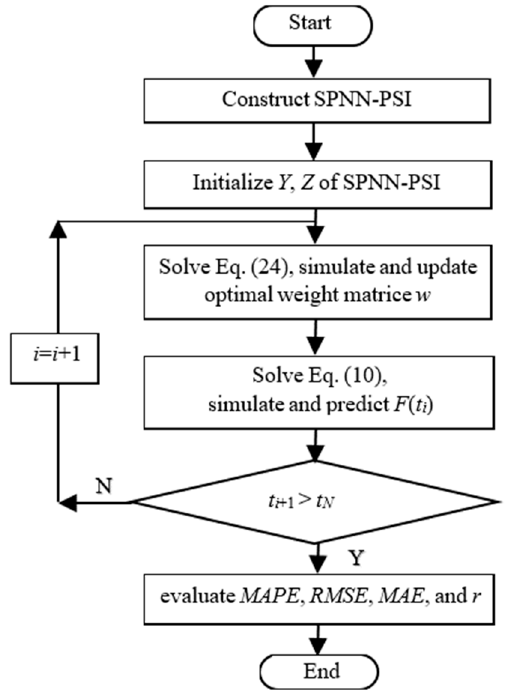
Figure 3. The flow chart of the optimized network model.